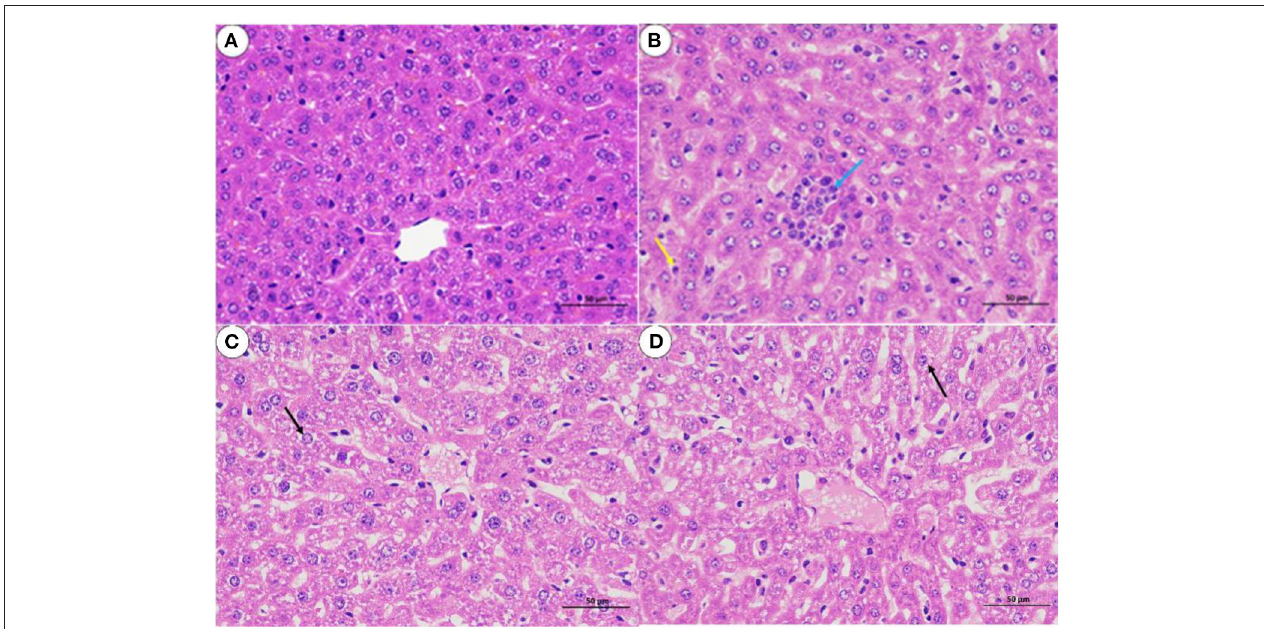
FIGURE 7 | Liver sections from mice (H. E, 400 X). (A) blank control group; (B) bacterial challenge group; (C) phage group; (D) treatment group; inflammatory cells (blue arrow); white blood cells (yellow arrow); particle degeneration (black arrow).